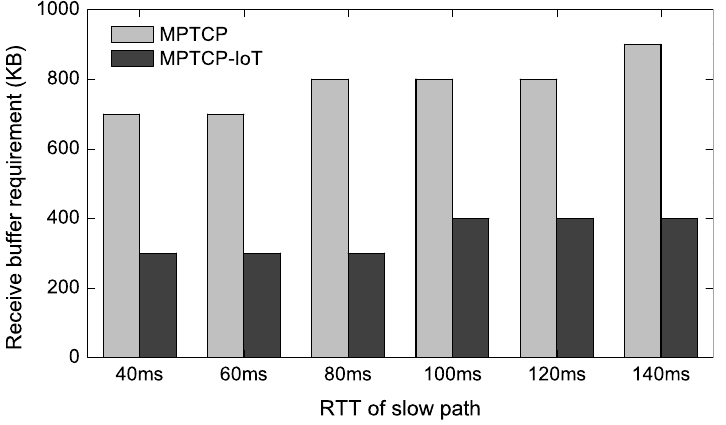
Figure 6. Receive-buffer requirement of IoT